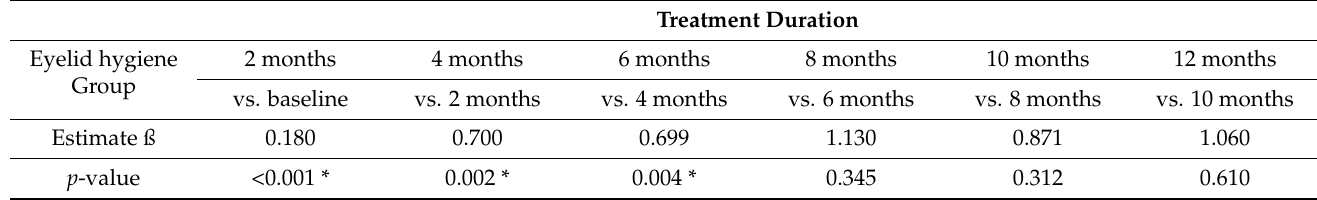
Table 3. Impact of eyelid hygiene on meibomian gland dysfunction treatment duration. Table 4. Impact of discontinuity of eyelid hygiene on meibomian gland dysfunction by withdrawal